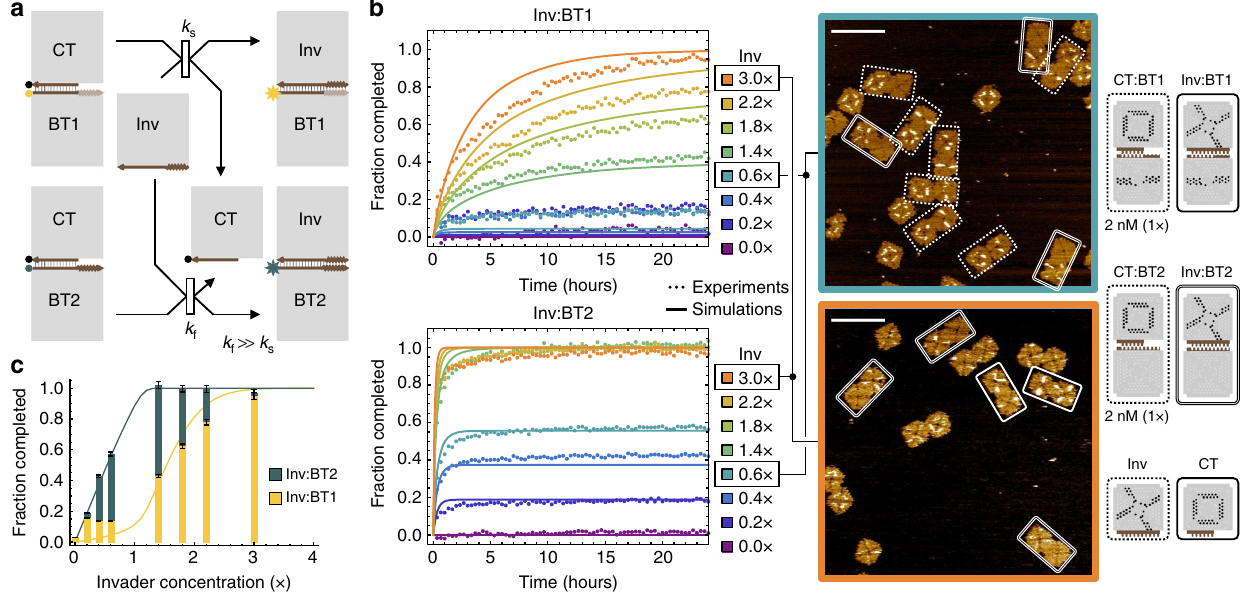
Fig. 2 Competitive recon fi guration. a Domain-level diagram of two competing tile displacement reactions. BT1 and BT2 are base tiles with 1-nt and 2-nt sticky end in 4 toehold staples, respectively. They are labeled with two distinct fl uorophores for the two reactions to be monitored simultaneously. k s and k f are effective rates of the two reactions, respectively. b Fluorescence kinetics experiments, simulations, and AFM images of competitive tile displacement. 1× corresponds to a standard concentration of 2 nM. Dotted and two types of solid boxes highlight reactants and two types of products, respectively. Scale bars are 200 nm. c Completion level of competitive tile displacement at 24 h (bars) overlaid with simulations (lines). It is clear from the kinetics trajectories shown in b that the completion levels for Inv:BT2 with invader concentration from 1.4× through 3.0× have reached maximum reaction completion, and that the difference in these completion levels re fl ects the noise in the experimental measurements. Thus, error bars correspond to the standard deviation of these four completion levels, scaled proportionally to each of the 16 completion